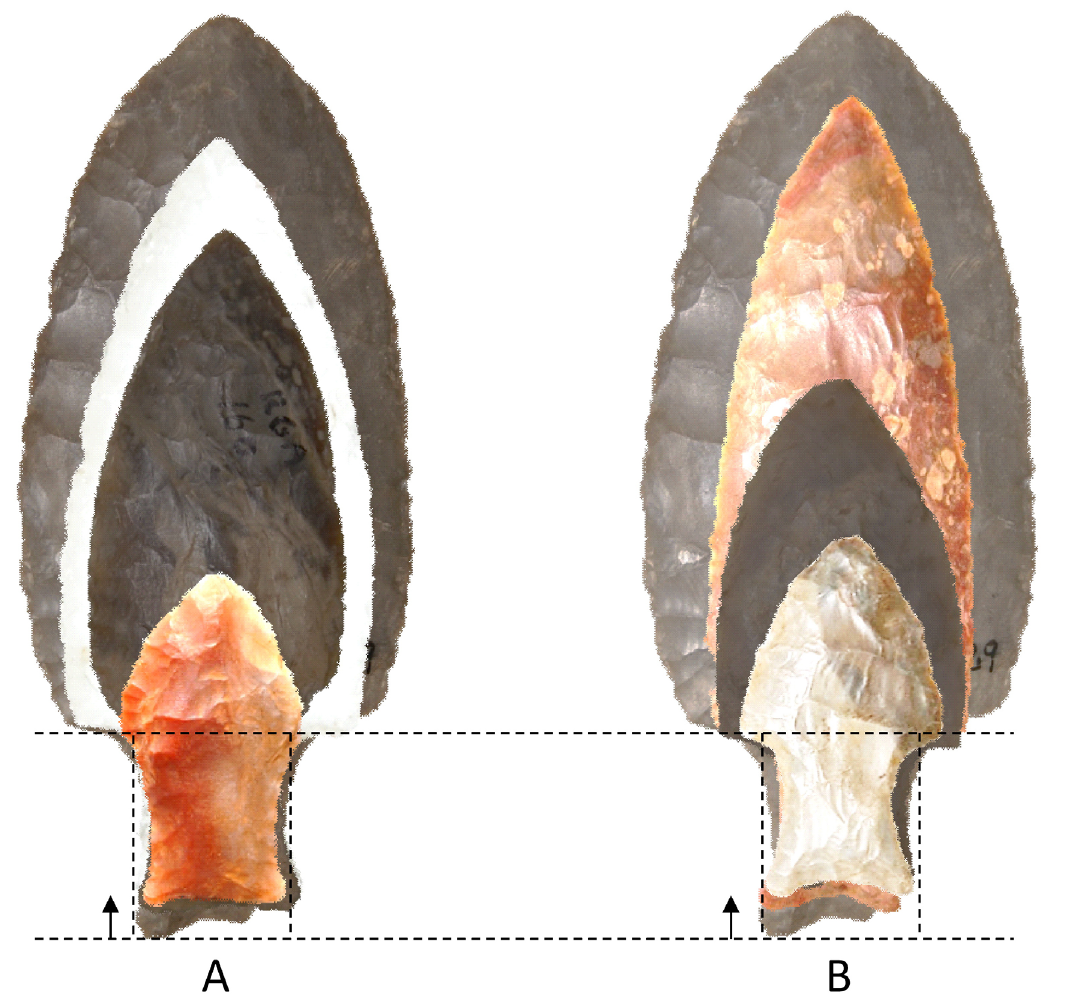
Figure 20. Schematic overlay of some of the points included in this study, featuring different original designs and simple rejuvenation process of blade and the stem (see text). Note that the quadrangular shape of the stem, and their low size variation, focused on the ears. The Example B shows the straight shoulder from larger to smaller points. The figures are slightly